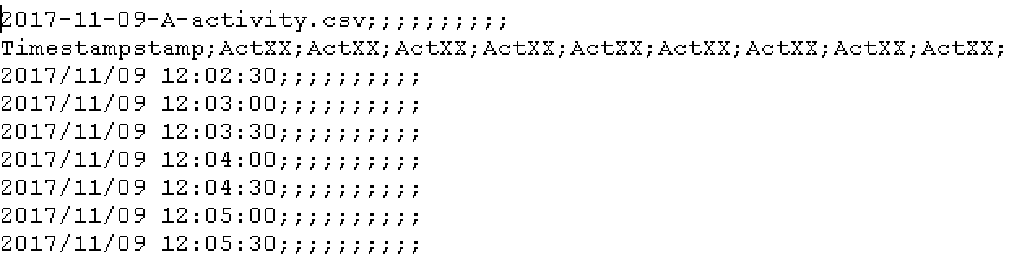
Figure 8. An excerpt from the file named results.xls.